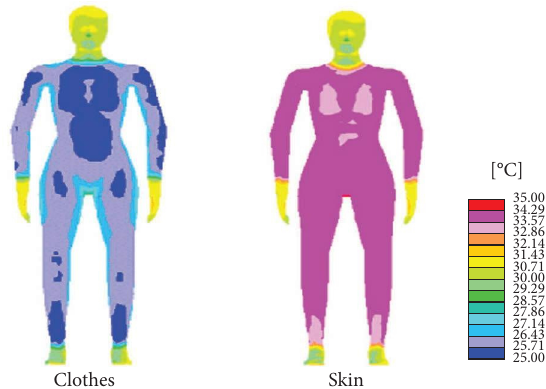
Figure 5: Covered vs. uncovered human skin temperatures